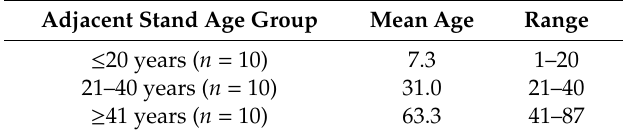
Table A1. Distribution of mean age and age range of adjacent forest